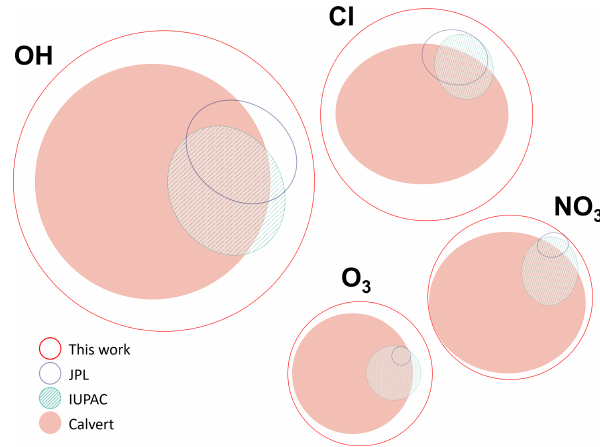
Figure 1. Area-proportional Venn diagrams constructed using the eulerAPE software (Micallef and Rodgers, 2014). The size and po- sition of each curve is proportional to the number of species studied with respect to each oxidant, the number of compounds available in each review, and the overlap between these